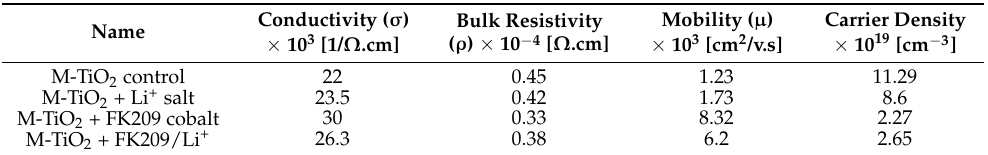
Table 1. Electrical properties of the undoped M-TiO 2 control and M-TiO 2 doped with FK209, FK209/Li + and Li +